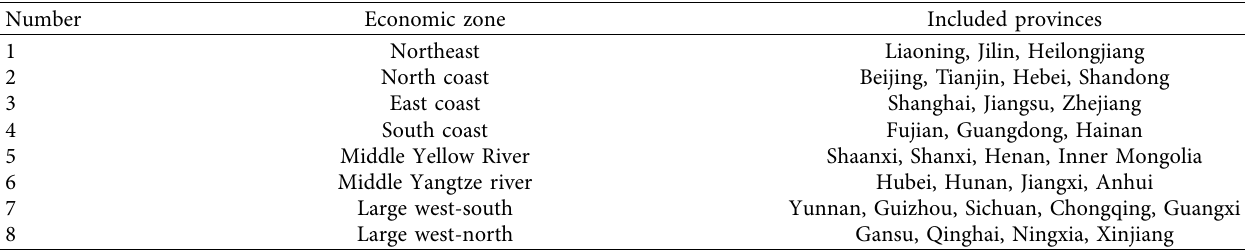
Table 1: Eight economic-zone divisions in